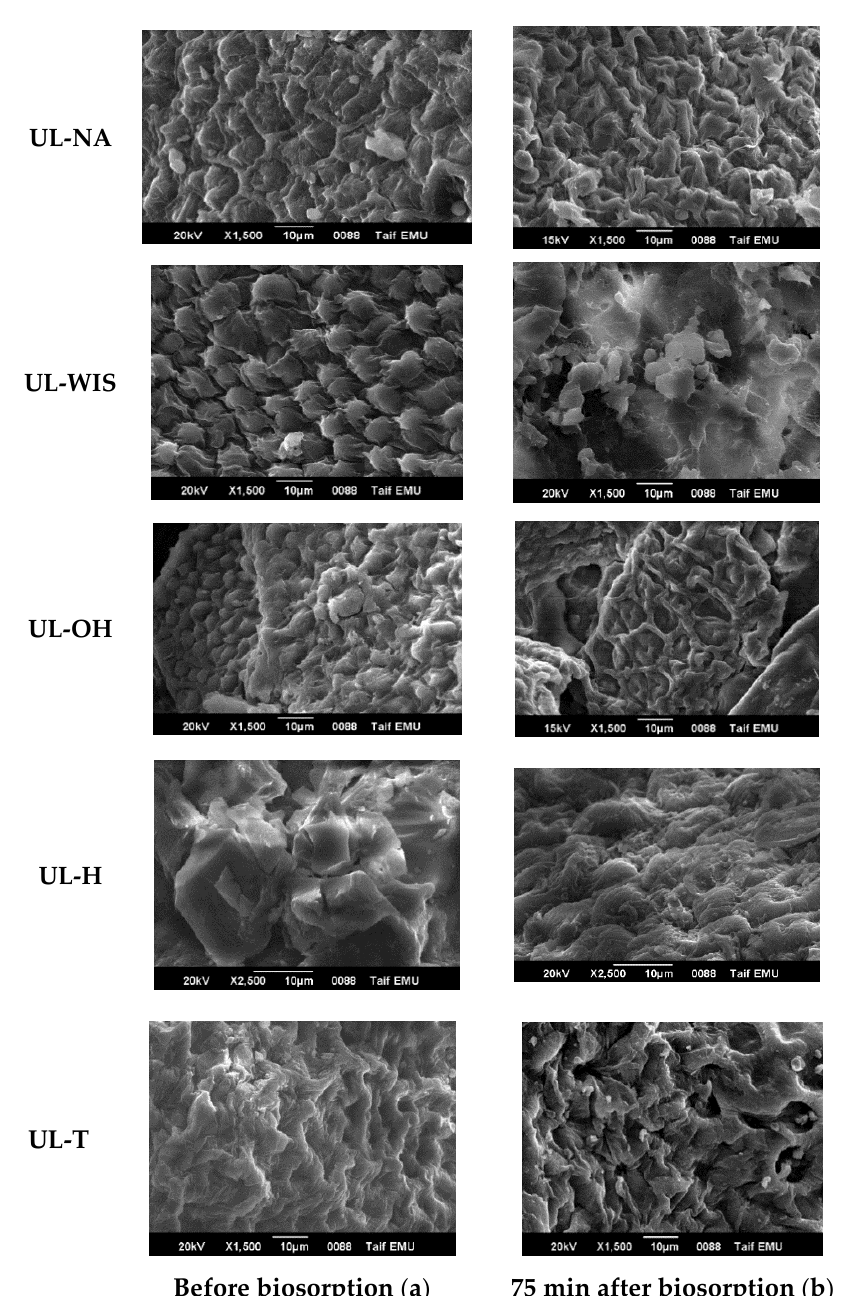
Figure 6. SEM micrograph of raw dry U. lactuca (UL-NA), UL-WIS, and different treated U. lactuca (UL-OH, UL-H, UL-T) before ( a ) and after ( b ) 75 min of contact with MB, at 1500 magnification.